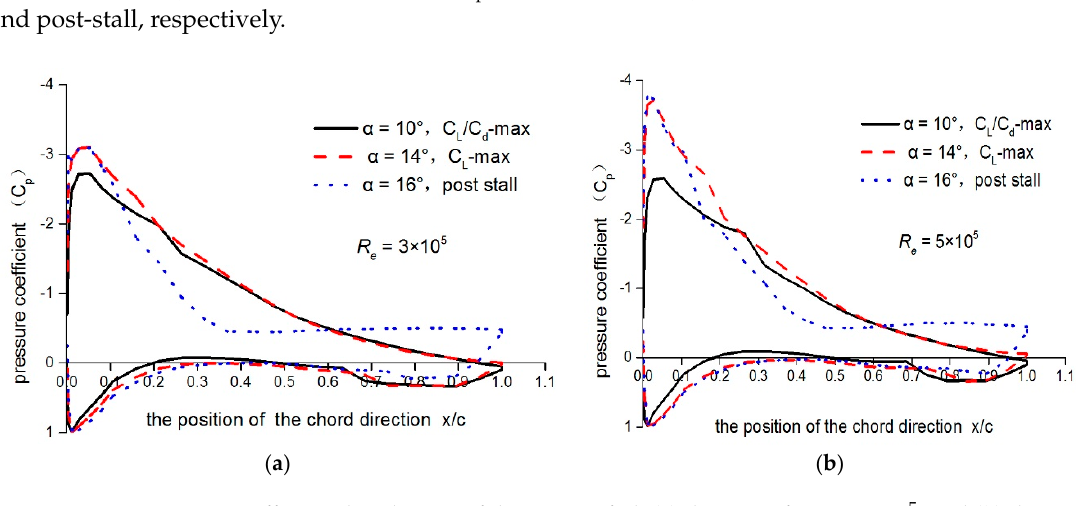
Figure 7. Pressure coefficient distribution of the LUT airfoil: ( a ) the case of R e = 3 × 10 5 ; and ( b ) the case of R e = 5 × 10 5 . The data were measured when the surface of the LUT airfoil was clean. The lines in black, red, and blue show the pressure coefficients corresponding to angles of attack of C L /C d -max, C L -max, and post-stall, respectively.